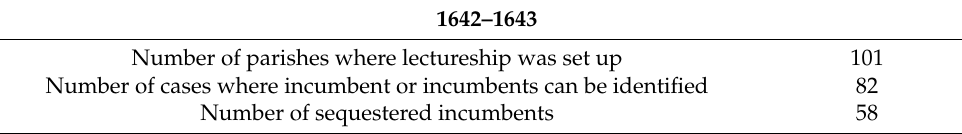
Table 1. Sequestration of Incumbents.